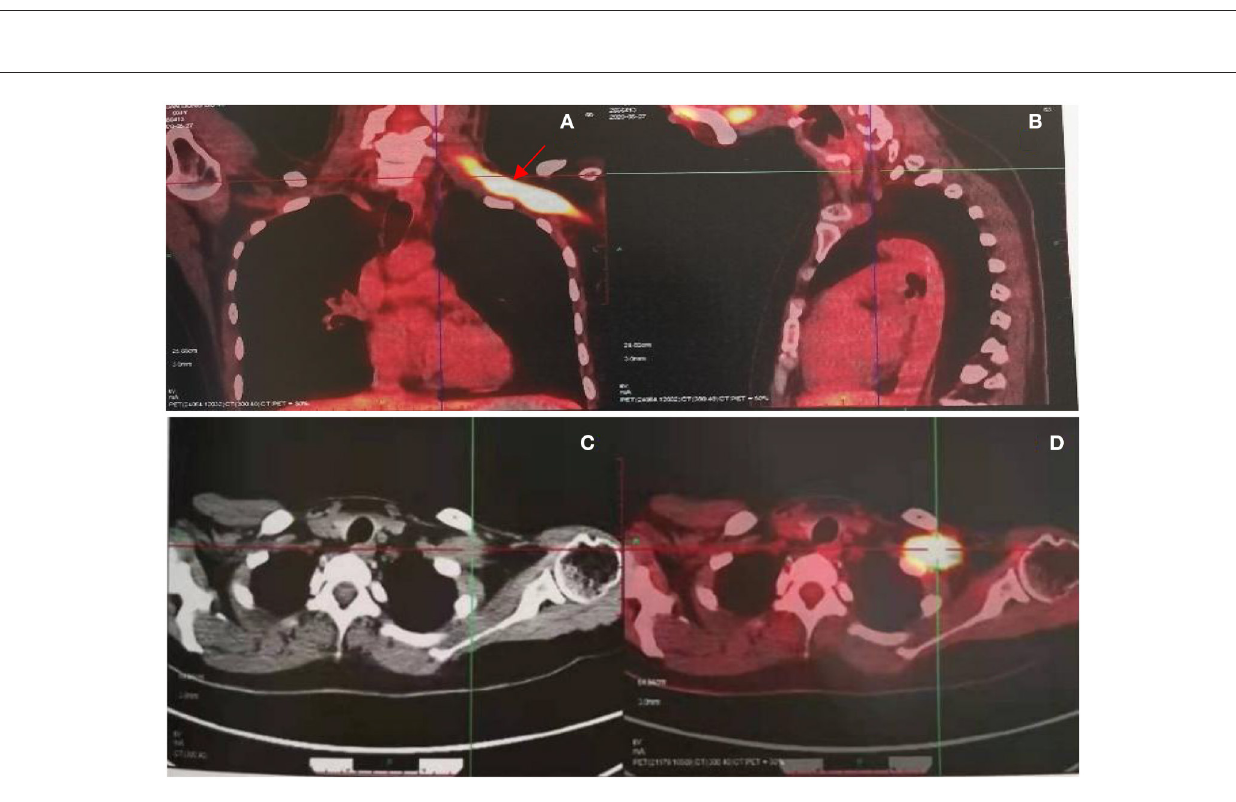
FIGURE3 PET CT revealed increased radioactive uptake in the left brachial plexus (SUV max 24.4) (A, B) , involving a length of 9.3cm (C, D)